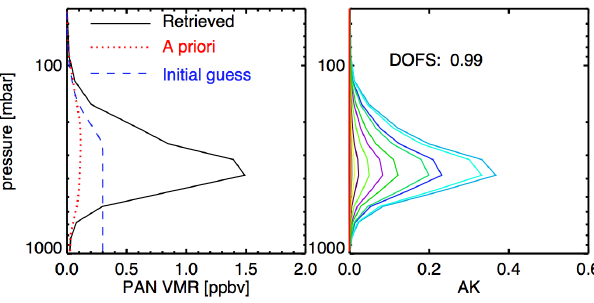
Figure 5. Left: Example TES PAN retrieval for a measurement within a boreal fire plume. Right: 2 Figure 5. Left: example TES PAN retrieval for a measurement Averaging kernels for this example. 3 within a boreal fire plume. Right: averaging kernels for this exam-